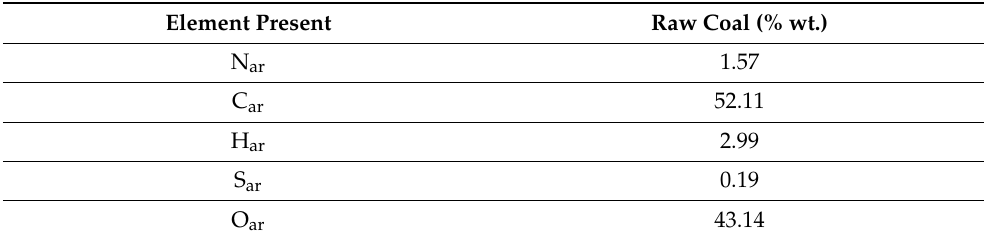
Table 4. Raw bituminous coal ultimate analysis on as received basis. Element